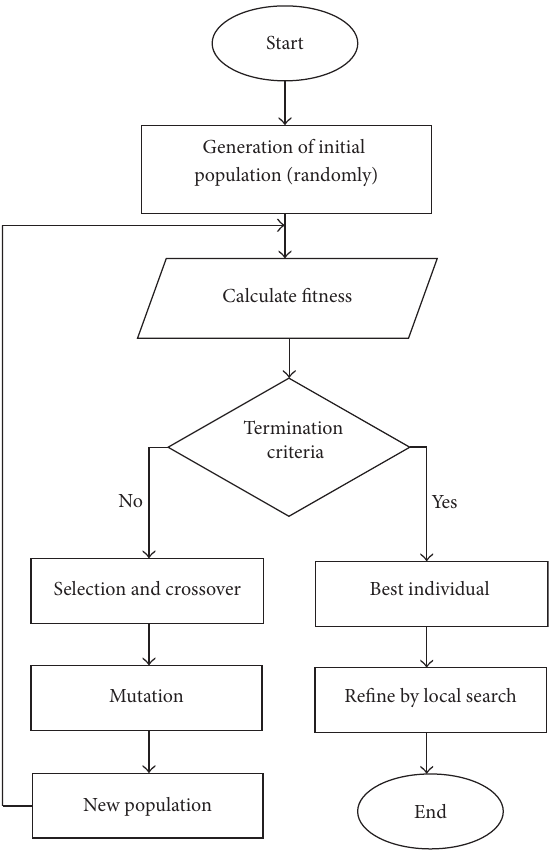
Figure 2: Generic structure of the hybrid intelligent approach.